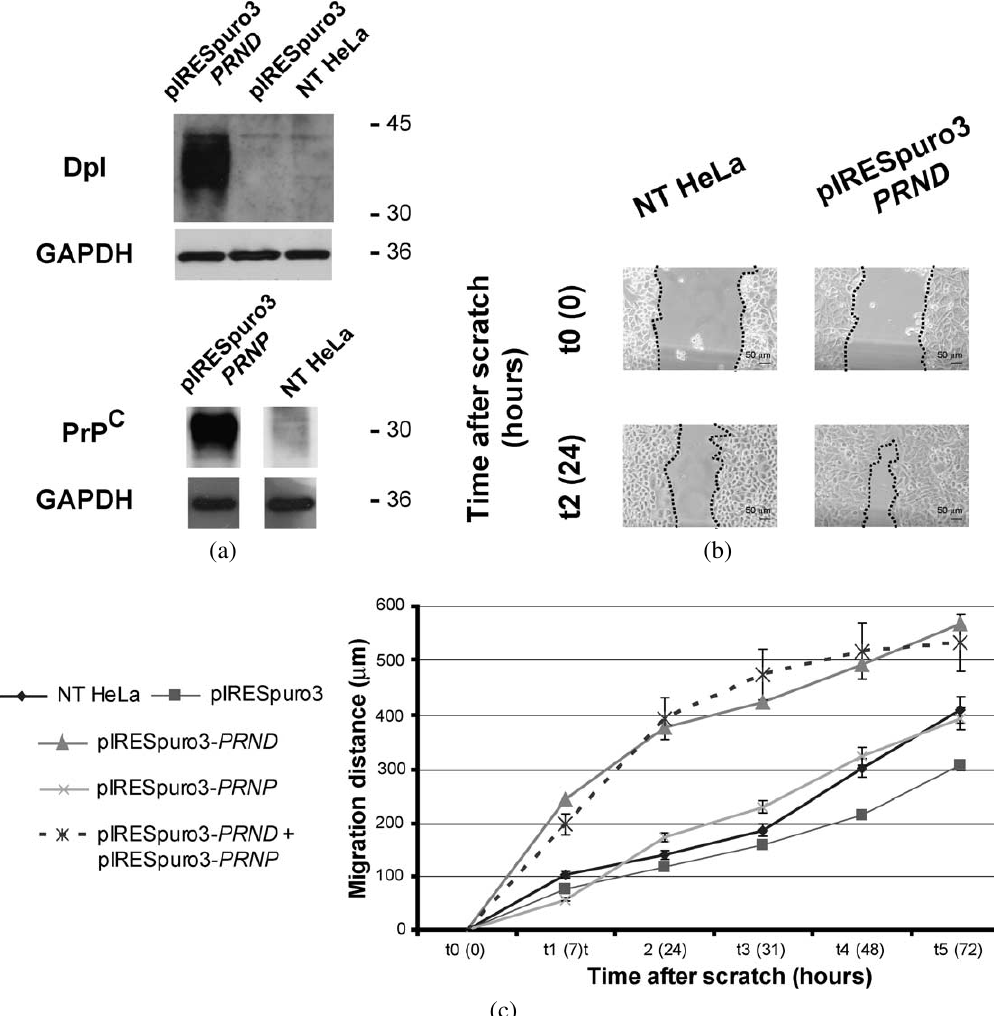
Fig. 2. Stably selected HeLa cells and migratory behaviour analysis. (a) Western blot analysis of HeLa cells overexpressing Dpl (pIRE- Spuro3- PRND ) and PrP C (pIRESpuro3- PRNP ) respects to the empty-vector transfectants (pIRESpuro3) and the not-transfected (NT HeLa) con- trols. (b) The snapshots of the cell monolayer scratches indicate the increased migration rate for the overexpressing HeLa (pIRESpuro3- PRND ) respects to the untreated cells (NT HeLa), observed at 24 h after scratch. Scale bars are reported (50 µm). (c) The migration rate curves of the sta- bly transfected HeLa cells expressing Dpl (pIRESpuro3- PRND ) or co-expressing both Dpl and PrP C (pIRESpuro3- PRND + pIRESpuro3- PRNP ) proteins show a higher value respect to, respectively, untreated (NT HeLa), empty vector transfectants (pIRESpuro3) and PrP C expressing cells (pIRESpuro3- PRNP ). Statistical analysis was performed by Student’s t test ( p < 0 .